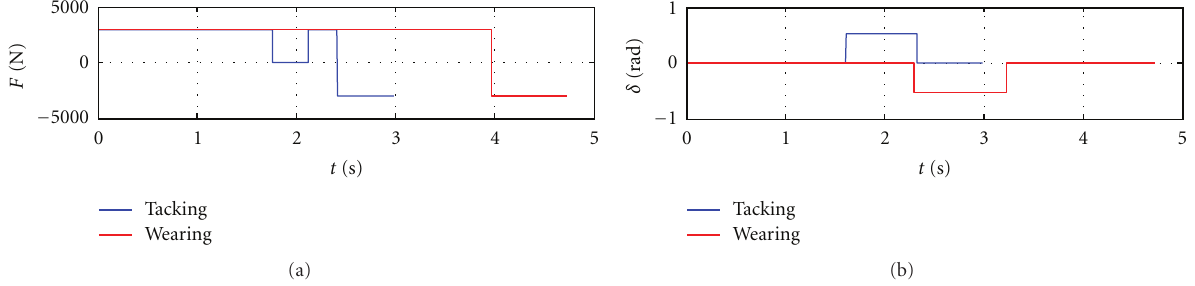
Figure 7: Control inputs for tacking and wearing maneuvers. (a) External force profile and (b) steering angle.